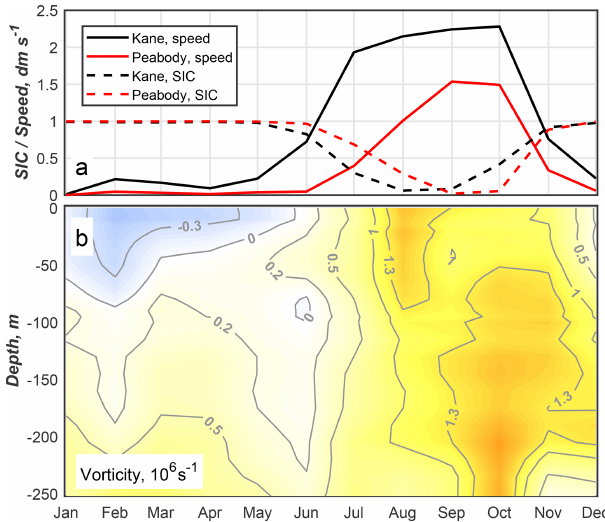
Figure 8. (a) The mean monthly SIC (dashed lines) and drift speeds (solid lines) within the main channel of Kane Basin (black) and in Peabody Bay (red). (b) The seasonal evolution of mean 2006–2010 vorticity within Peabody Bay. Both datasets are calculated from FE- SOM